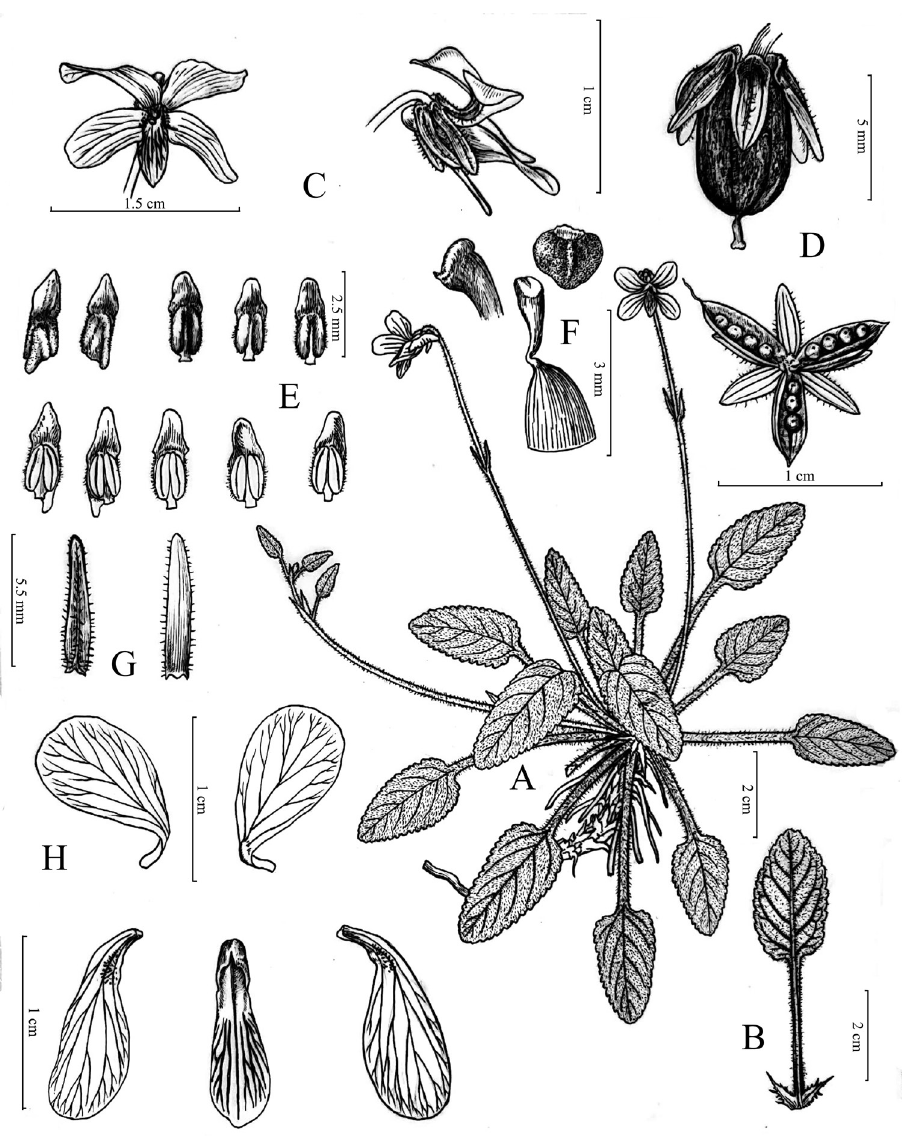
Figure 3. Viola huizhouensis A habit and flowering branch B leaf and stipules C flower, front view and lateral view D young capsule with sepals and bracteoles and dehiscent capsule with seeds E stamens in adaxial view (below) and abaxial view (above) F stigma and pistil G bracteoles H petals. each side of mid-rib, margin coarsely serrate, base cuneate. Flowers 15–18 mm diam.; pedicels slender, 6–10 cm long, pubescent, usually exceeding leaves, with two oppo- site bracteoles above middle; bracteoles lanceolate, pubescent, 4–8 mm long, margin entire, apex obtuse. Sepals green, pubescent, linear-lanceolate, 2.7–3.7 × 0.5–1 mm, margin entire, apex obtuse, base truncate or rounded. Petals whitish to light